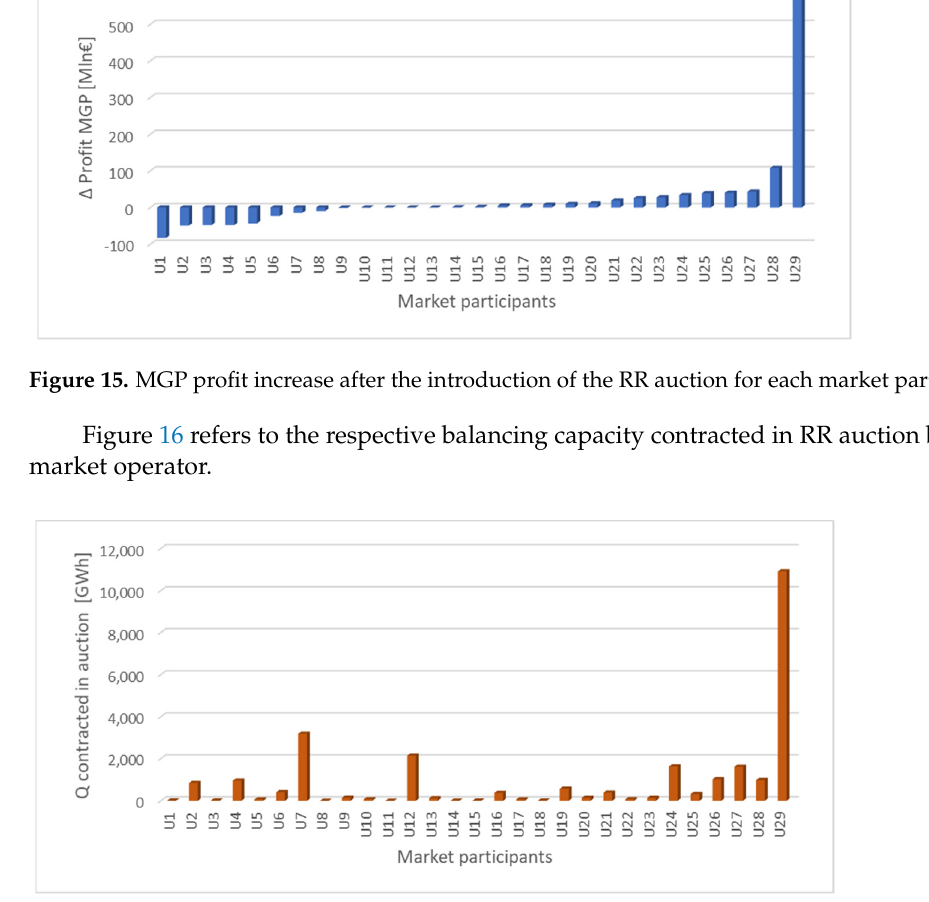
Figure 16. Balancing capacity contracted in RR auction by each market participant.